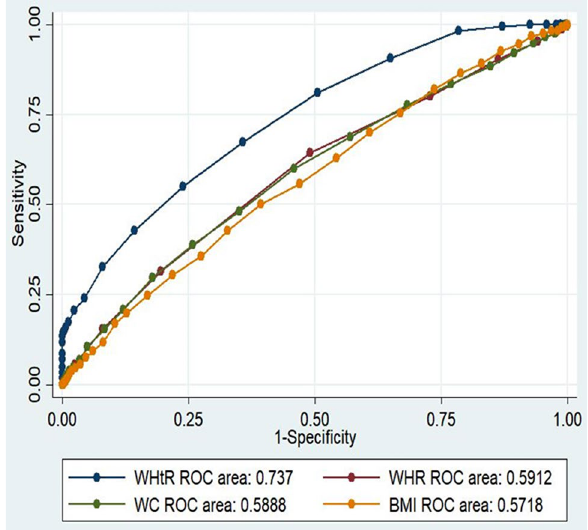
Figure 2. Comparison of AUC of the anthropometric indices for diagnosis of prevalent cardiac event in men.